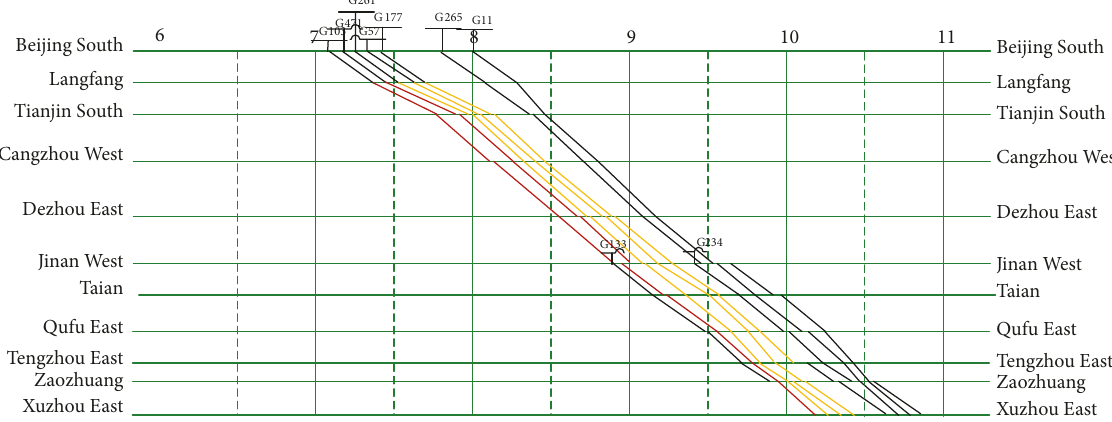
Figure 13: The optimal adjustment solution of the delay scheme